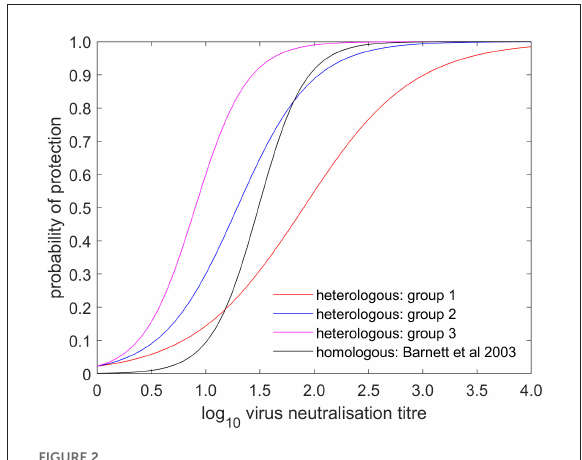
FIGURE2 Estimated probability that a vaccinated bovine animal is protected following challenge and its dependence on log 10 virus neutralisation titre. The plot shows the posterior median for the probability of heterologous protection for group 1 (comprising experiments 1 & 2; red), group 2 (comprising experiments 3, 4, 5, 6, 7, 11, & 18; blue) and group 3 (comprising experiments 8,